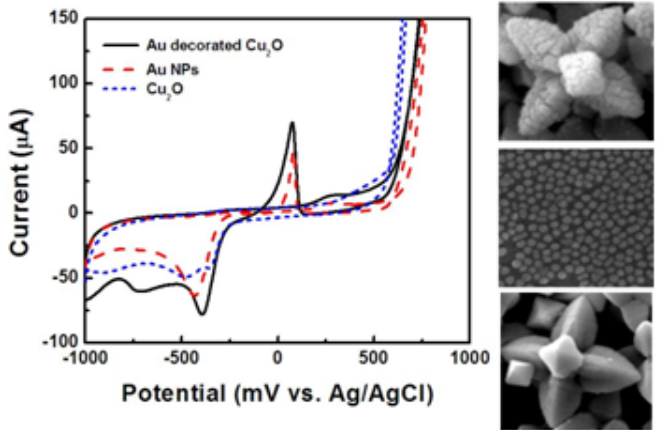
Figure 12. Cyclic voltammograms of electrodes coated with hexapod Au/Cu Au nanoparticles, and hexapod Cu O in 0.5 M NaOH solution, and in the presence of 10 mM 2 glucose and corresponding SEM images of the